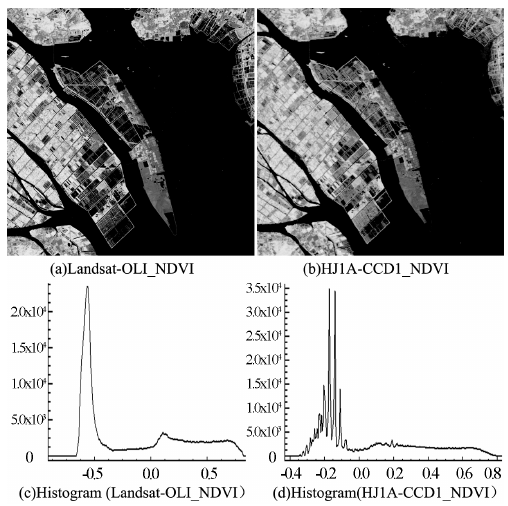
Figure 6. Normalized Difference Vegetation Index (NDVI) images and histogram graphs of Landsat-OLI and HJ1A-CCD1 data.